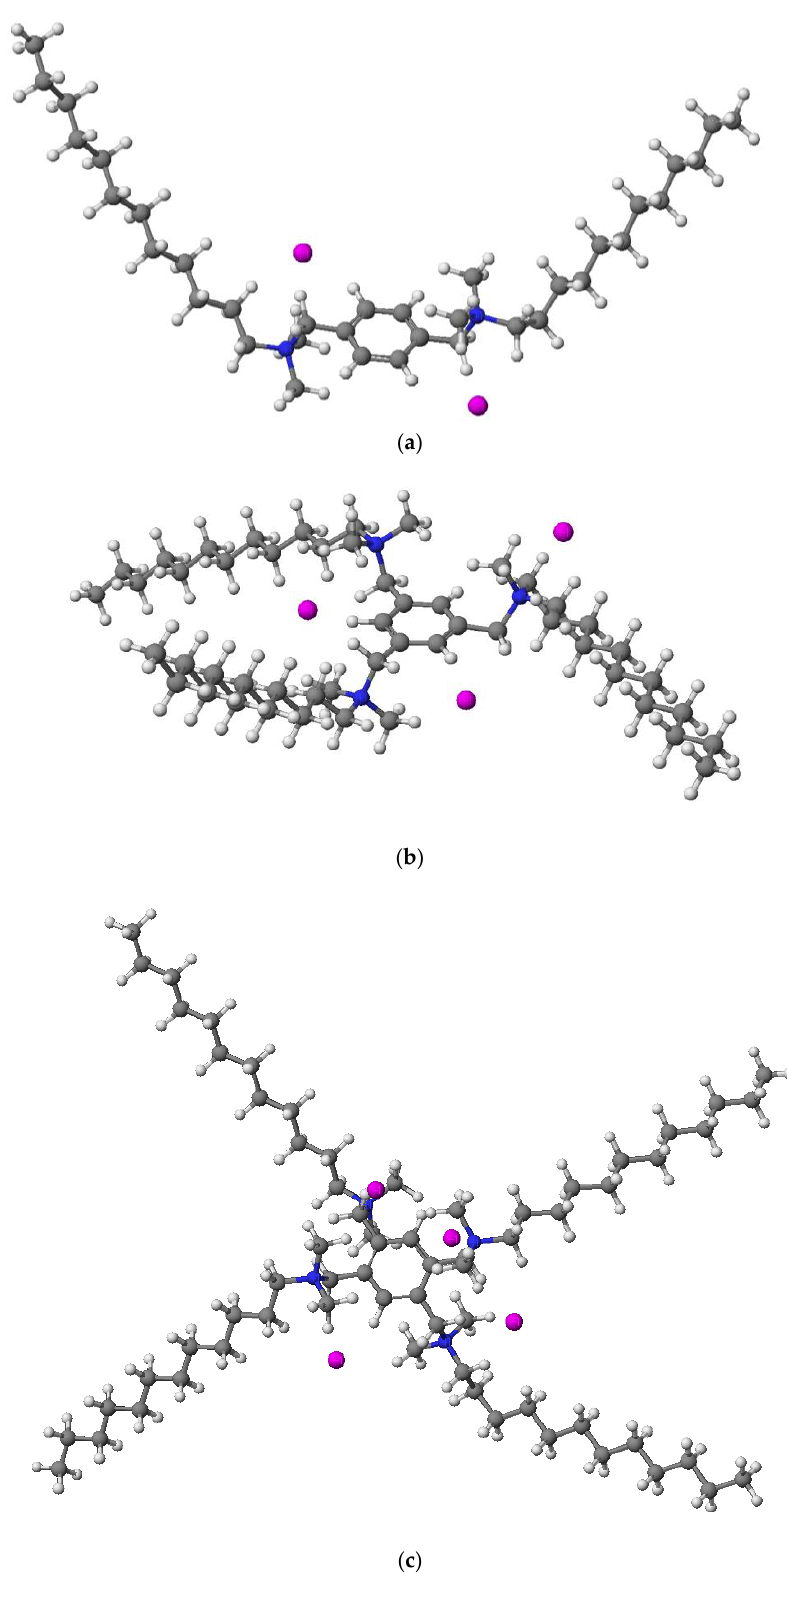
Figure 6. Molecular models of representative compounds 6 ( a ), 14 ( b ) and 21 ( c ) calculated by the PM5 method.